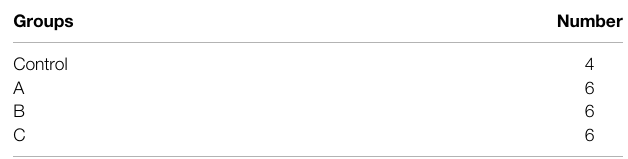
TABLE 2 | Number of the four group n-HA/PA66 scaffolds in vivo .